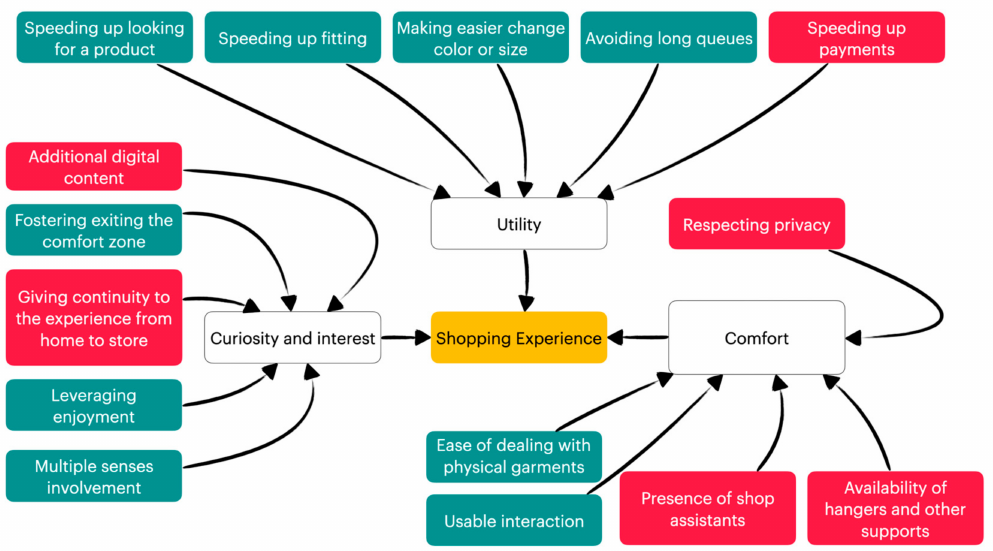
Figure 3. The three categories influencing the shopping experience and the elements that belong to